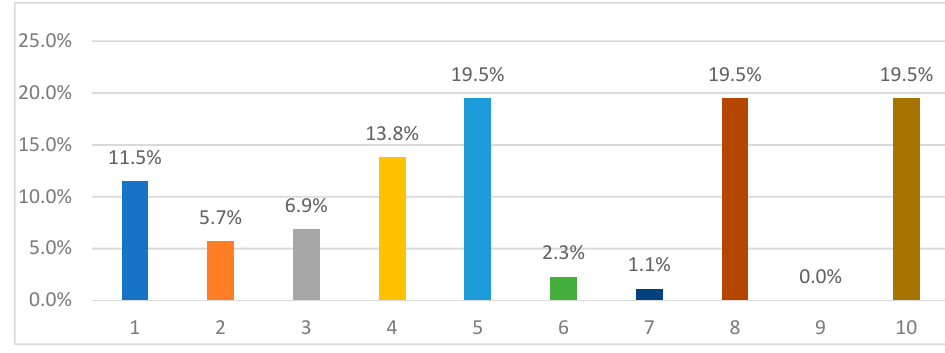
Figure 1. Anxiety levels.